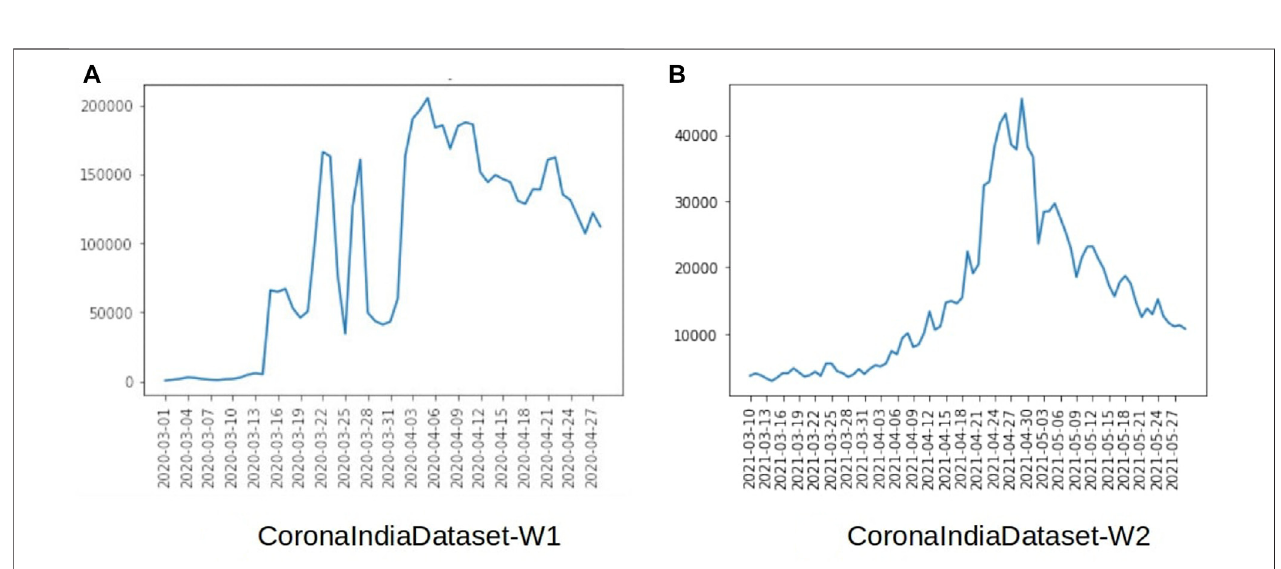
FIGURE 2 | Frequency of tweets v/s dates available in our